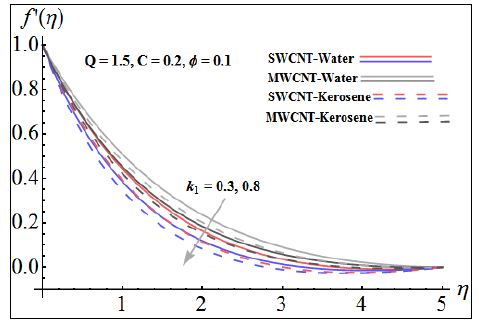
Figure 5. Behavior of f ′ ( η ) for increased values of 𝑘 (cid:2869) .